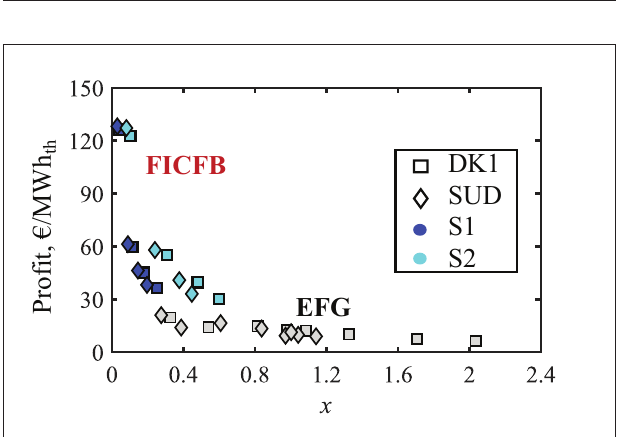
FIGURE 8 | Average annual utilization hours of the PowNeu mode with the case of FICFB-based plants highlighted.